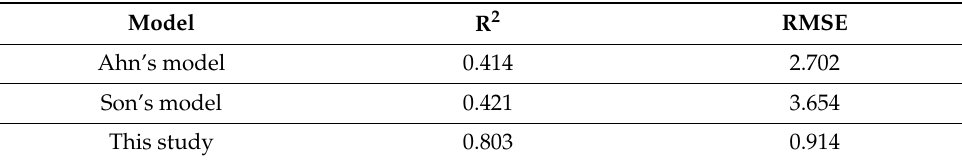
Figure 3. Comparisons of GOCI-derived SSS in this study with the results from ( a ) Ahn’s model and ( b ) Son’s model for the image acquired at 12:30 local time on 20 August 2016. Comparison of the results obtained with in situ SSS using 21 measurements from a test set for GOCI-derived SSS using ( c ) the model by Ahn et al. (2008) [2] and ( d ) the model by Son et al. (2018) [25]. Table 2. Summary of the algorithm performances.